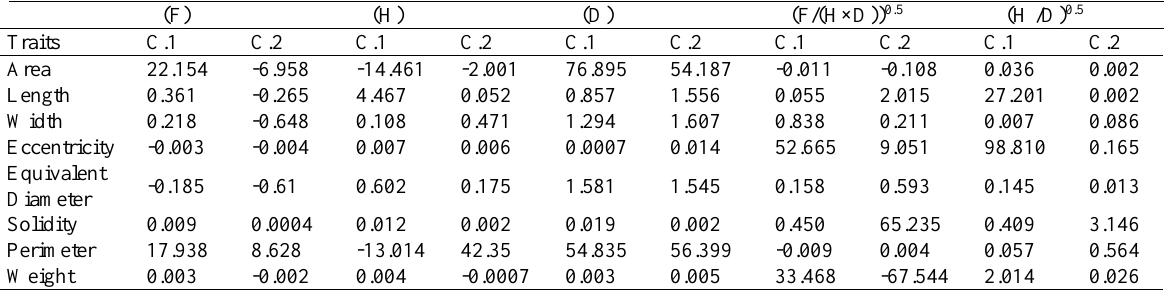
Table 2. Genetic parameters and components of variation for grain traits.